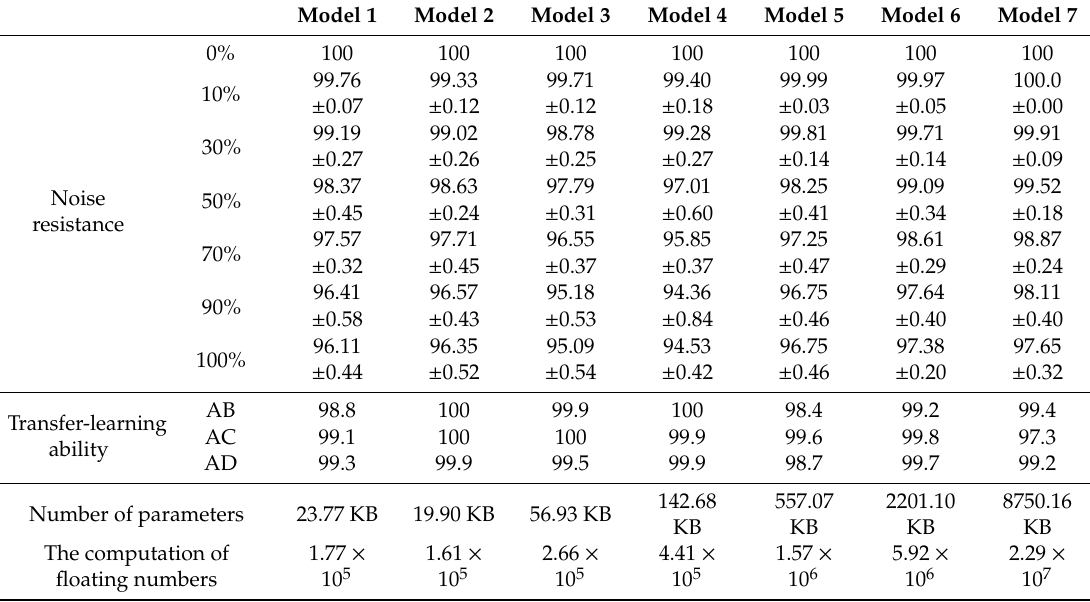
Table 8. Experimental results for the accuracy, noise resistance and transferability of various algorithms.